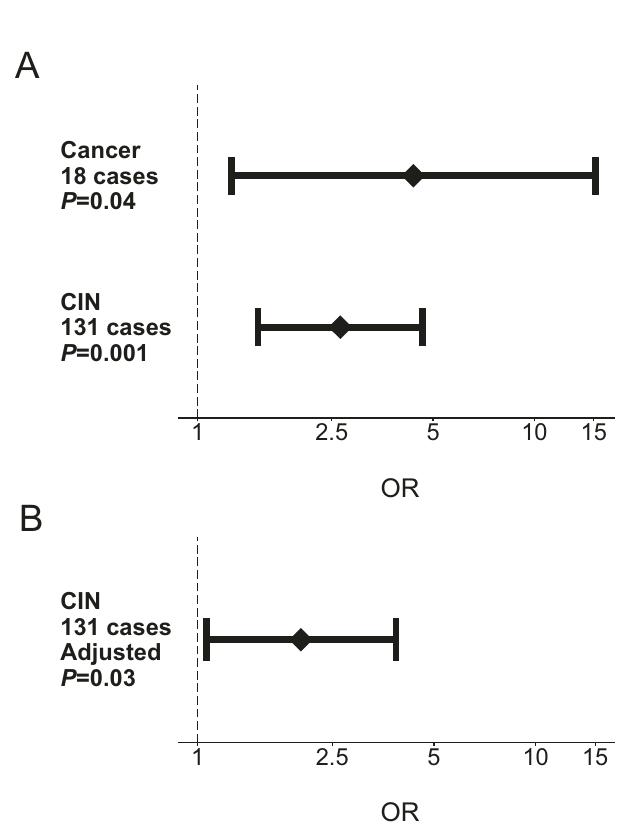
Fig. 2 Association between HPV-16 L1 antigen seropositivity and risk of cervical cancer and cervical intraepithelial neoplasia (CIN) in 9695 UK Biobank participants. A The diamonds represent unadjusted odds ratios of cervical cancer and cervical intraepithelial neoplasia by HPV-16 L1 seropositivity, shown with 95% con fi dence interval error bars ( P -values calculated with two-sided Fisher ’ s exact test). B Odds ratio and 95% con fi dence interval of CIN risk after adjustment for age, sex, ethnicity, LSP and TDI ( P -value calculated using multivariable regression